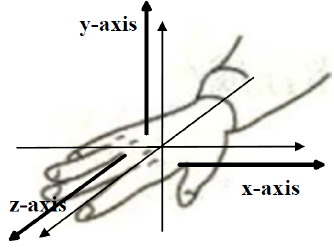
Figure 6. Five typical orientation subclasses: ( a ) palm inward; ( b ) hand upward; ( c ) hand downward; ( d ) palm up; and ( e ) palm down.